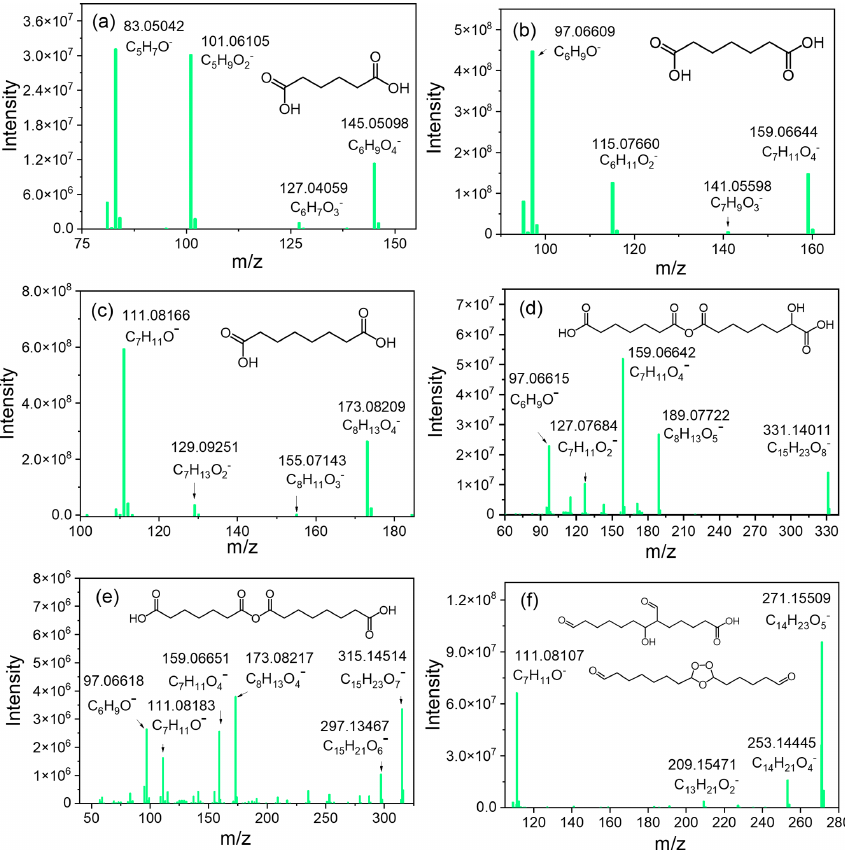
Figure 4. MS/MS spectra of major monomers and dimers. Monomers: (a) C 6 H 10 O 4 , (b) C 7 H 12 O 4 , and (c) C 8 H 14 O 4 . Dimers: (d) C 15 H 24 O 8 , (e) C 15 H 24 O 7 , and (f) C 14 H 24 O 5